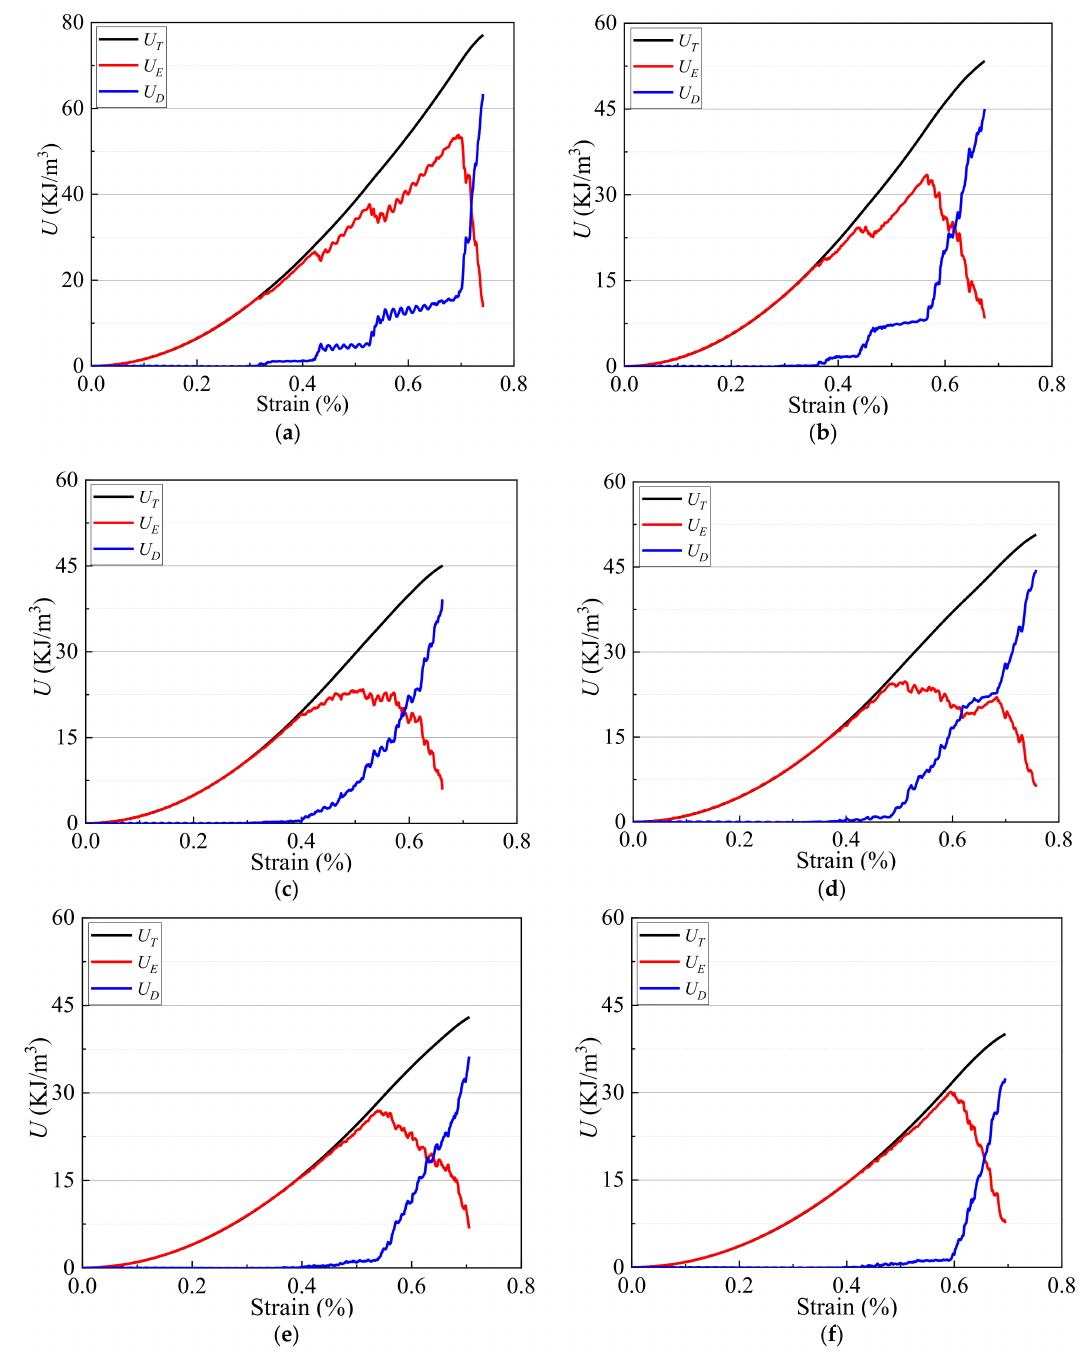
Figure 10. Energy evolution of different RCF samples: ( a – f ):